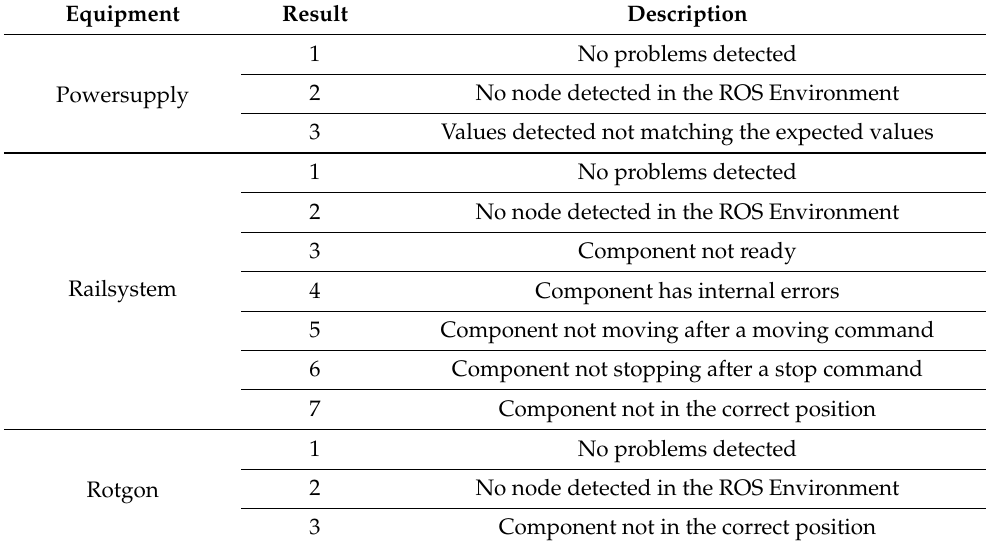
Table 1. Sanity check error